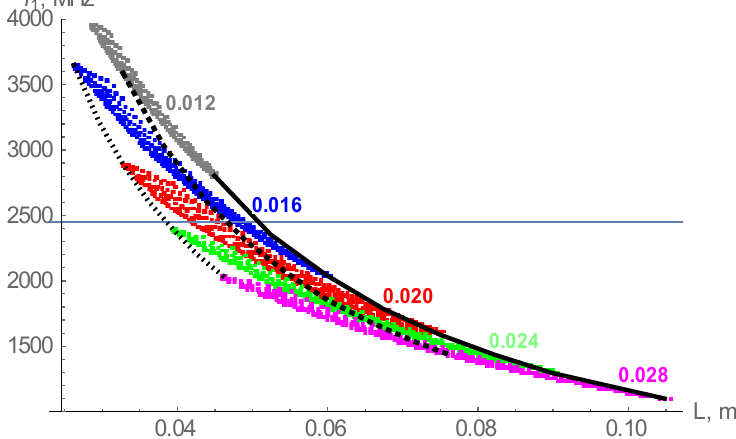
Figure 4. Dependence of the base frequency f 1 on the length of the arm’s wire for various scales. The wire diameter is 0.4 mm. The blue color indicates the calculation results of 440 antennas with various central vertices for v = 0.016 m, etc. The black curves show the dependences at a continuous change in scale for a specific Koch prefractal: the solid line corresponds to the antenna with a central vertex at (0.725, 0.775); the dashed line is for (0.576, 0.538); and the dotted line is for (0.475, 0.25).